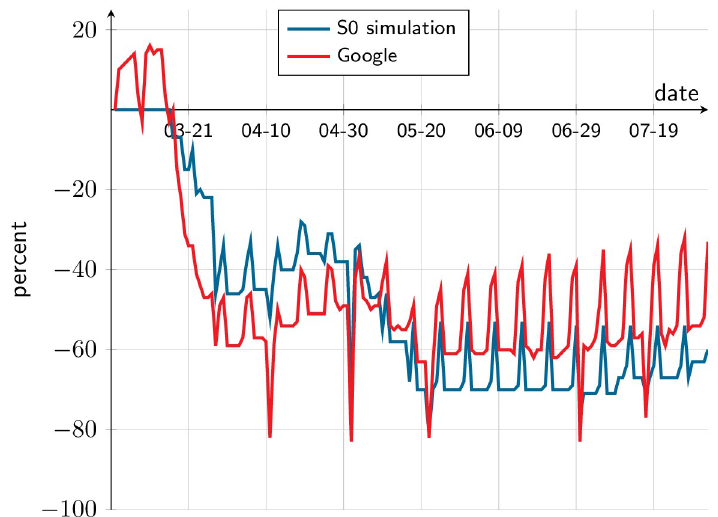
Fig 7. Mobility indices. The red line is Google’s labor-related mobility index, namely, the change in duration of stay in workplace with respect to same weekday of a reference week. The blue line is the same, as computed from simulations of the S0